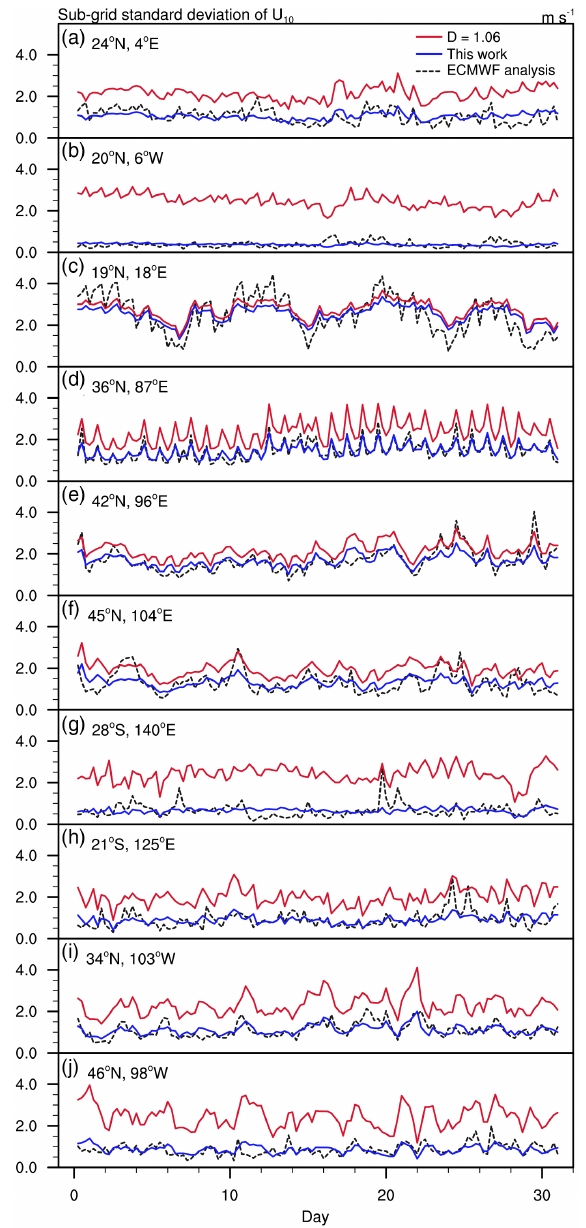
Figure 11. Time series of the sub-grid standard deviation of U 10 (ms − 1 ) in January 2012 in the 2 ◦ lat × 2 ◦ long grid cells indicated by red boxes in Fig. 10. Dashed black curves are results derived from the ECMWF 15km analysis. Red curves are results estimated using Eq. (27) with D = 1 . 06. Blue curves are also estimates using Eq. (27), but with location-dependent D calculated from Eq. (26).